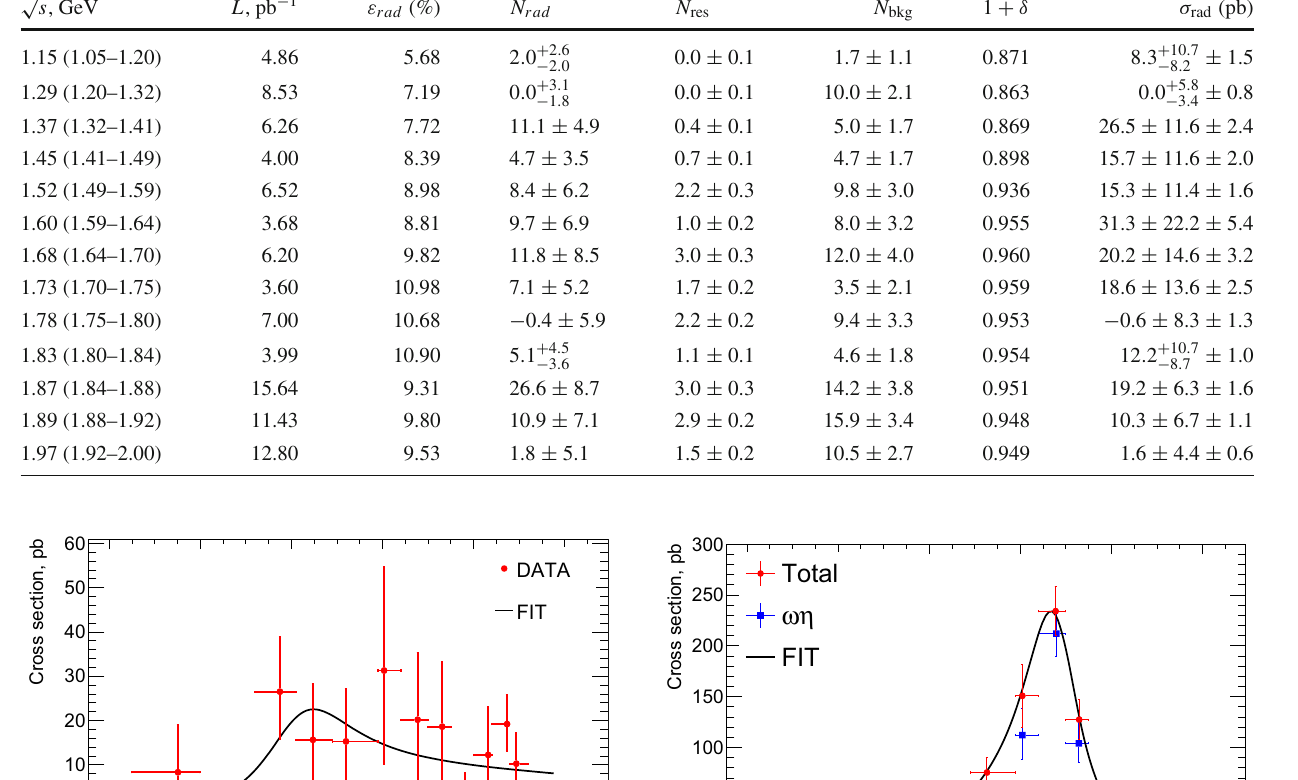
√ s ) for the interval indicated Table 4 The weighted average energy ( ber of background events ( N bkg ), radiative correction (1 + δ ), and Born in parentheses, integrated luminosity ( L ), detection efficiency ( ε rad ), cross section for the process e + e − → rad- ηπ 0 γ . For the cross section, number of selected events ( N rad ) for the process e + e − → rad- ηπ 0 γ , the first error is statistical, the second is systematic number of events from the processes e + e − → ρη , φη , φπ ( N res ), num-